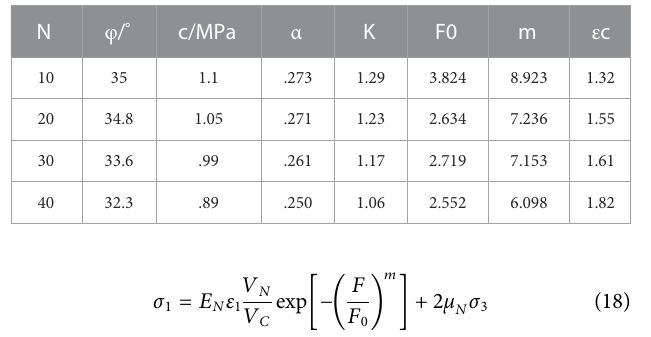
TABLE 2 Model parameters with different freeze-thaw times.